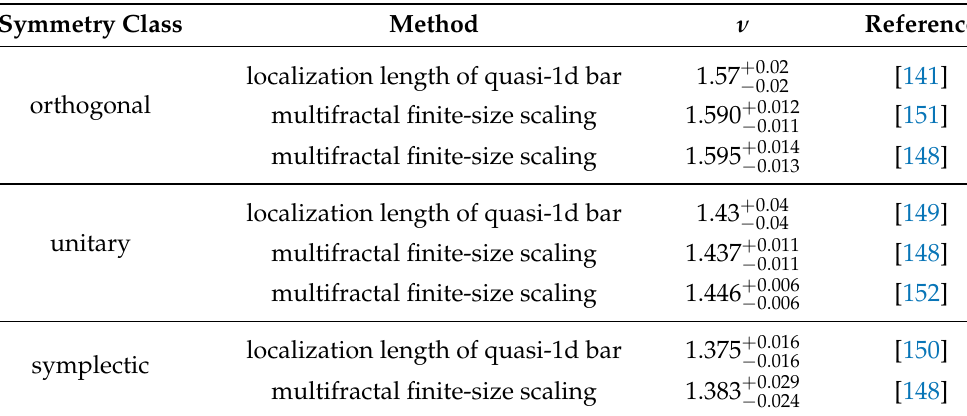
Table 2. Correlation-length critical exponent for Anderson transitions in the conventional symme- try